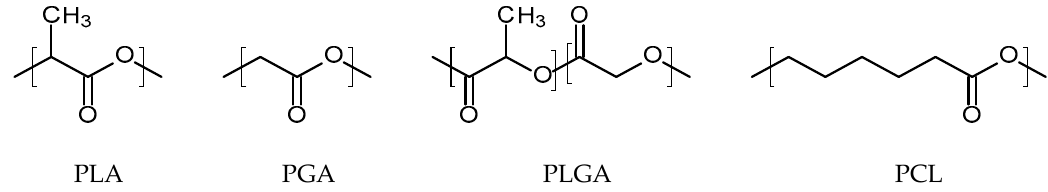
Figure 3. An illustration of the chemical structures of: poly(lactic acid) (PLA); poly(glycolic acid) (PGA); poly(lactic-co-glycolic acid) (PLGA); and poly(caprolactone) (PCL).